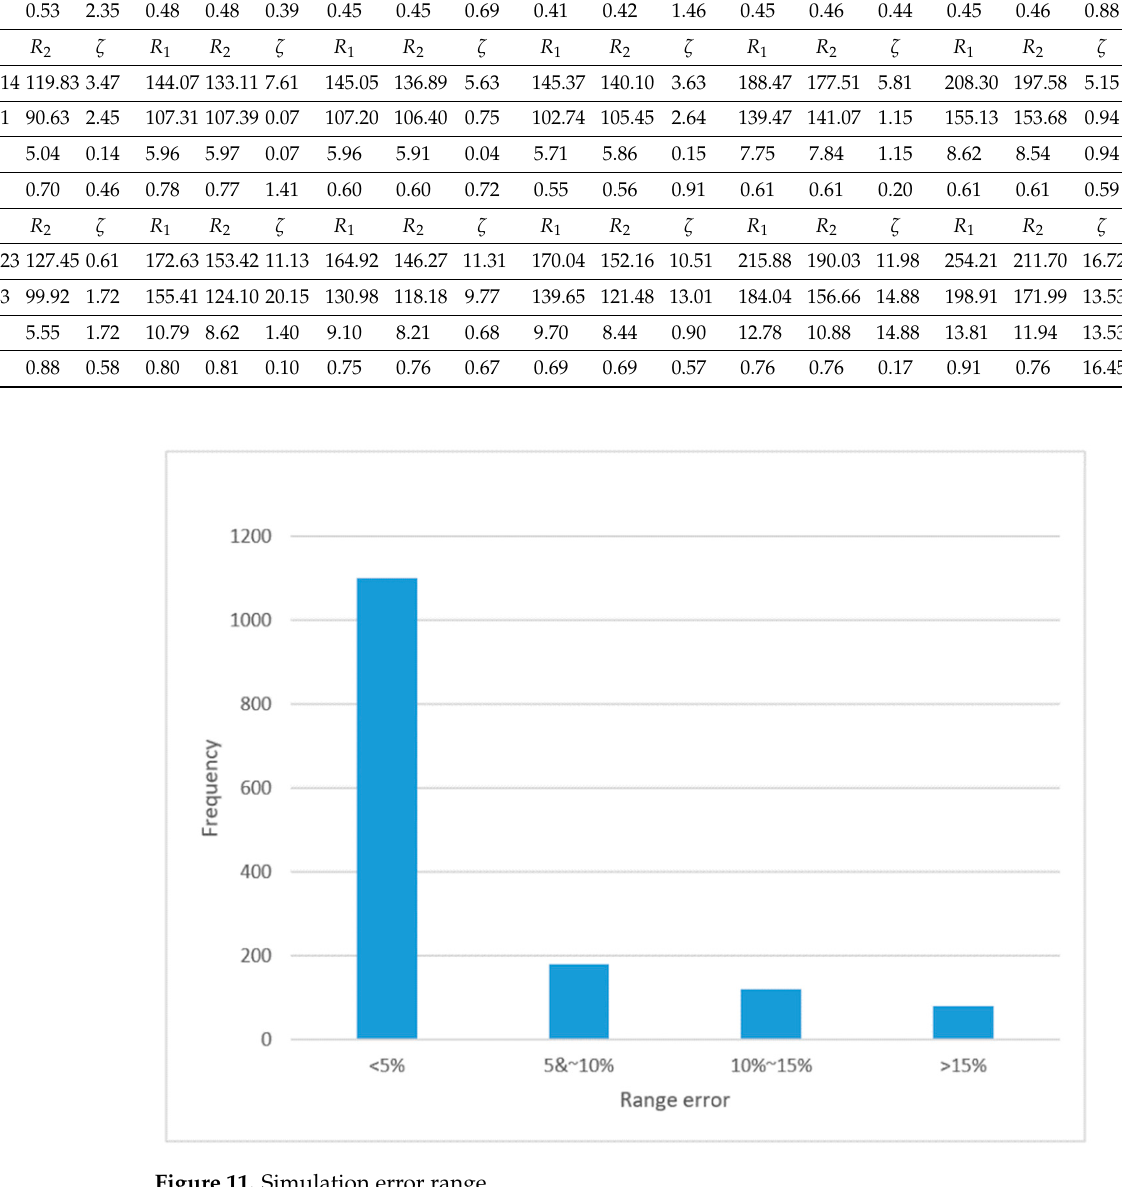
Figure 11. Simulation error range.